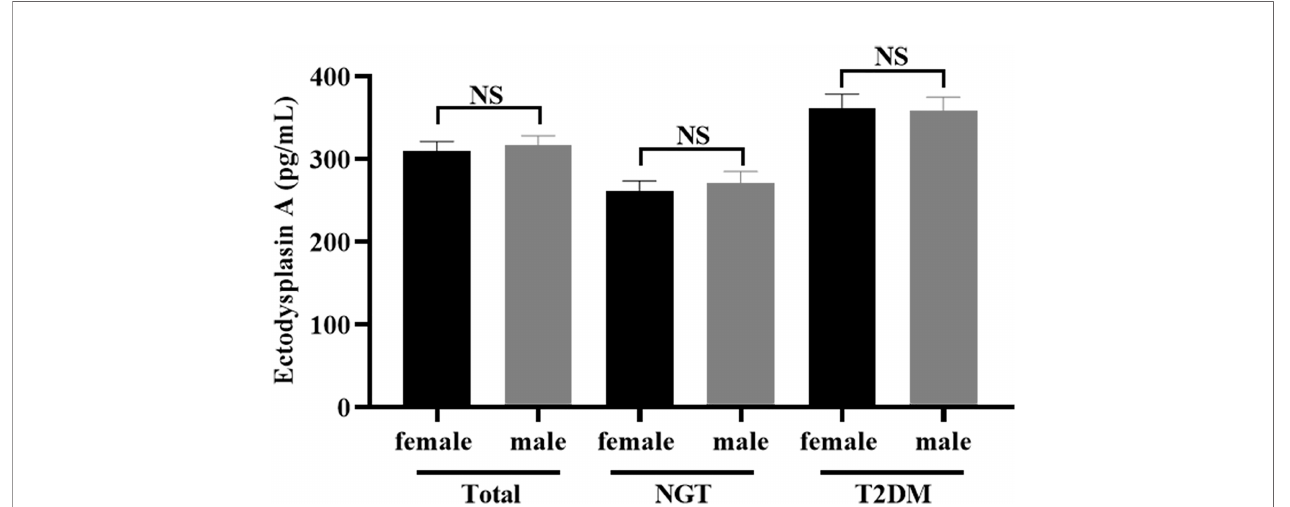
FIGURE 1 | Comparison of the serum concentration of EDA between women and men. No signi fi cant (NS): P > 0.05 was considered as no signi fi cant difference.